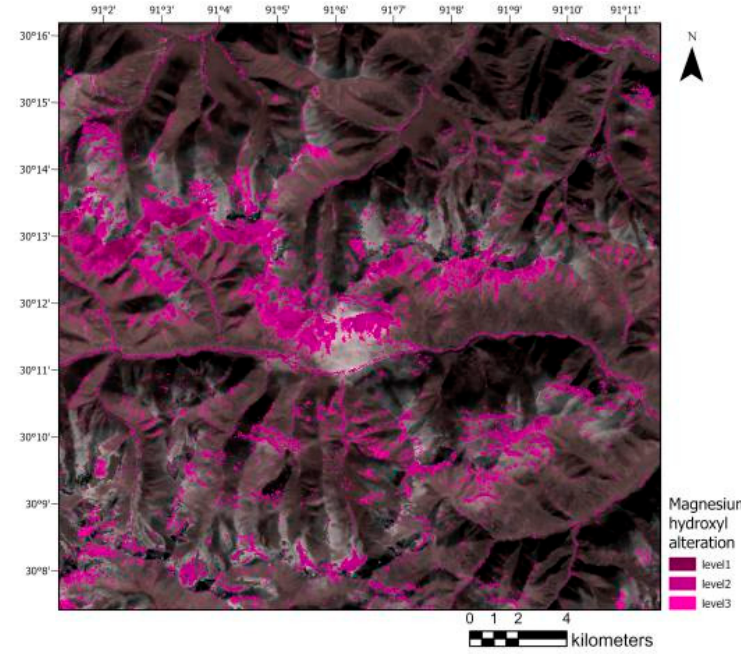
Figure 10. Magnesium hydroxyl alteration information in the enhanced band.